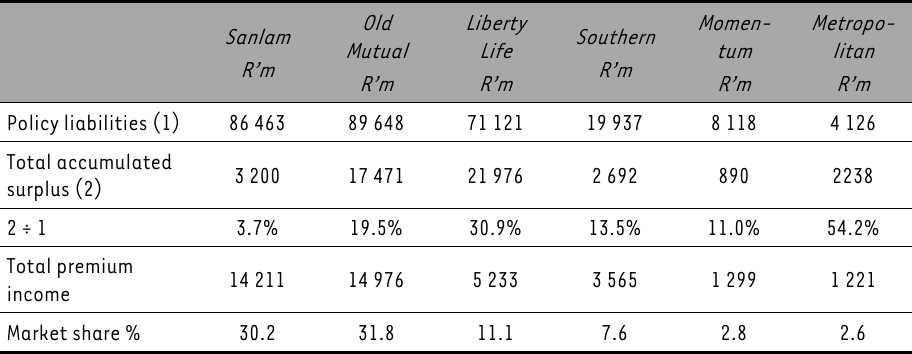
TABLE 7: The long-term insurance industry,